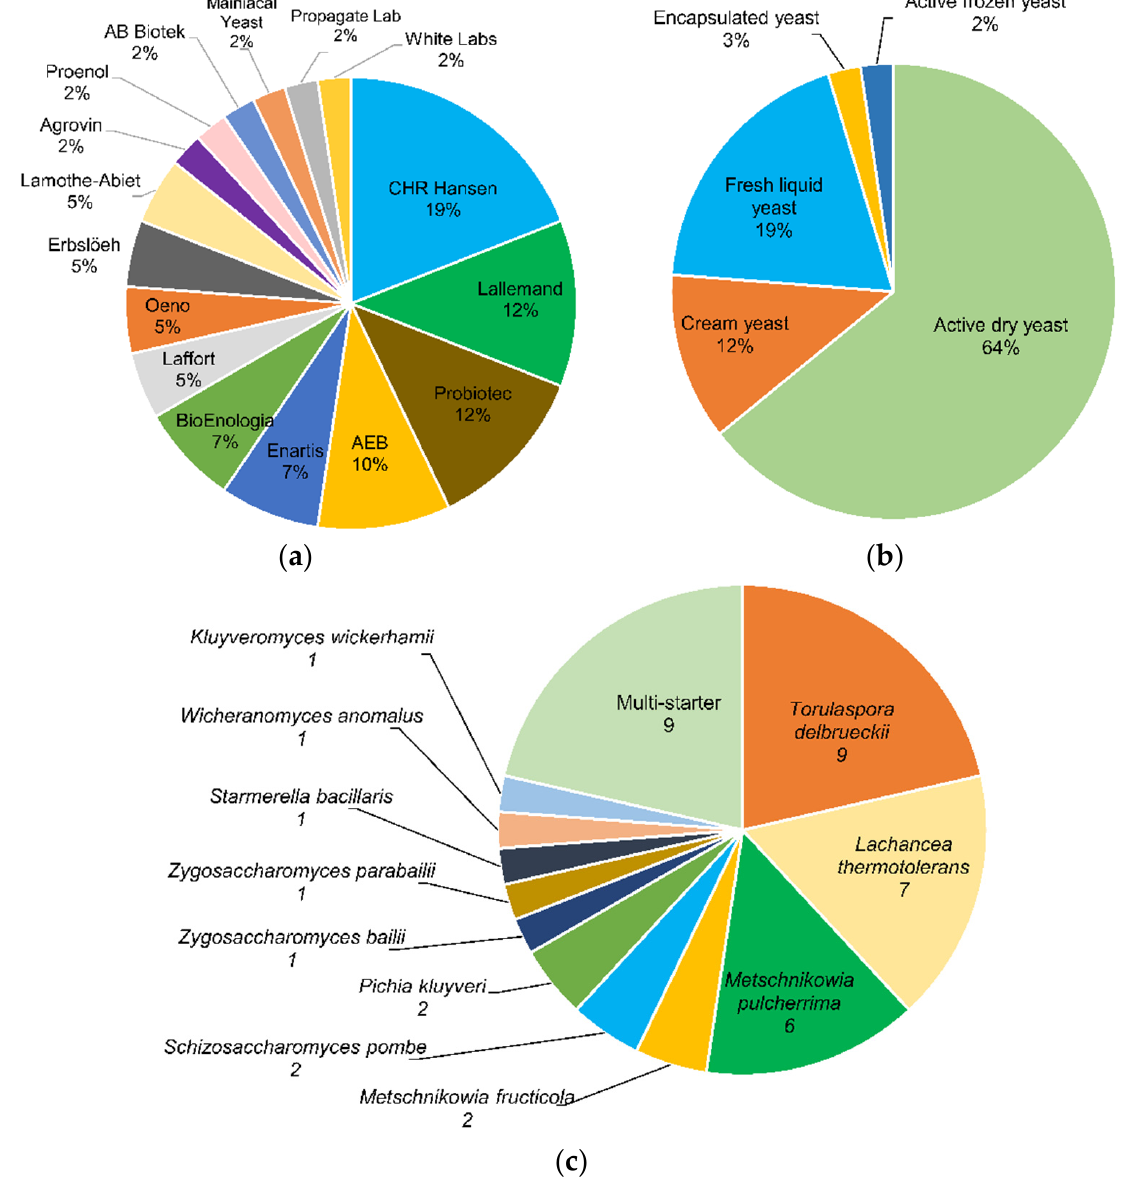
Figure 1. ( a ) Percentages of non- Saccharomyces based products offered by main companies (adapted from Roudil et al. [5] with updated information). ( b ) Formats (%) in which non- Saccharomyces are offered. ( c ) Number of commercial products based on non- Saccharomyces yeasts available in the market, by spe- cies.